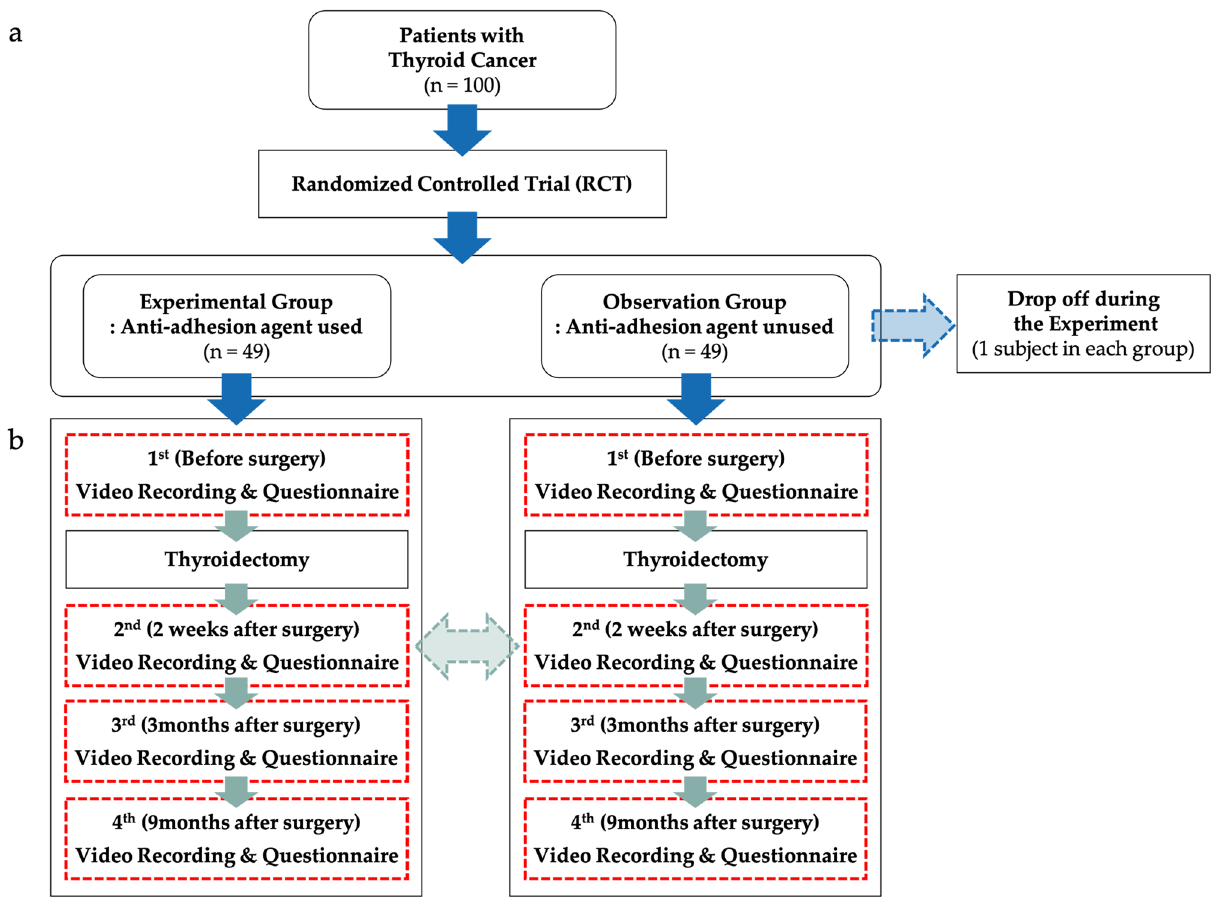
Figure 2. Study protocol. ( a ) Flow chart of the randomized controlled trial. ( b ) Anti-adhesion agent experiment (video recording and questionnaire) in each